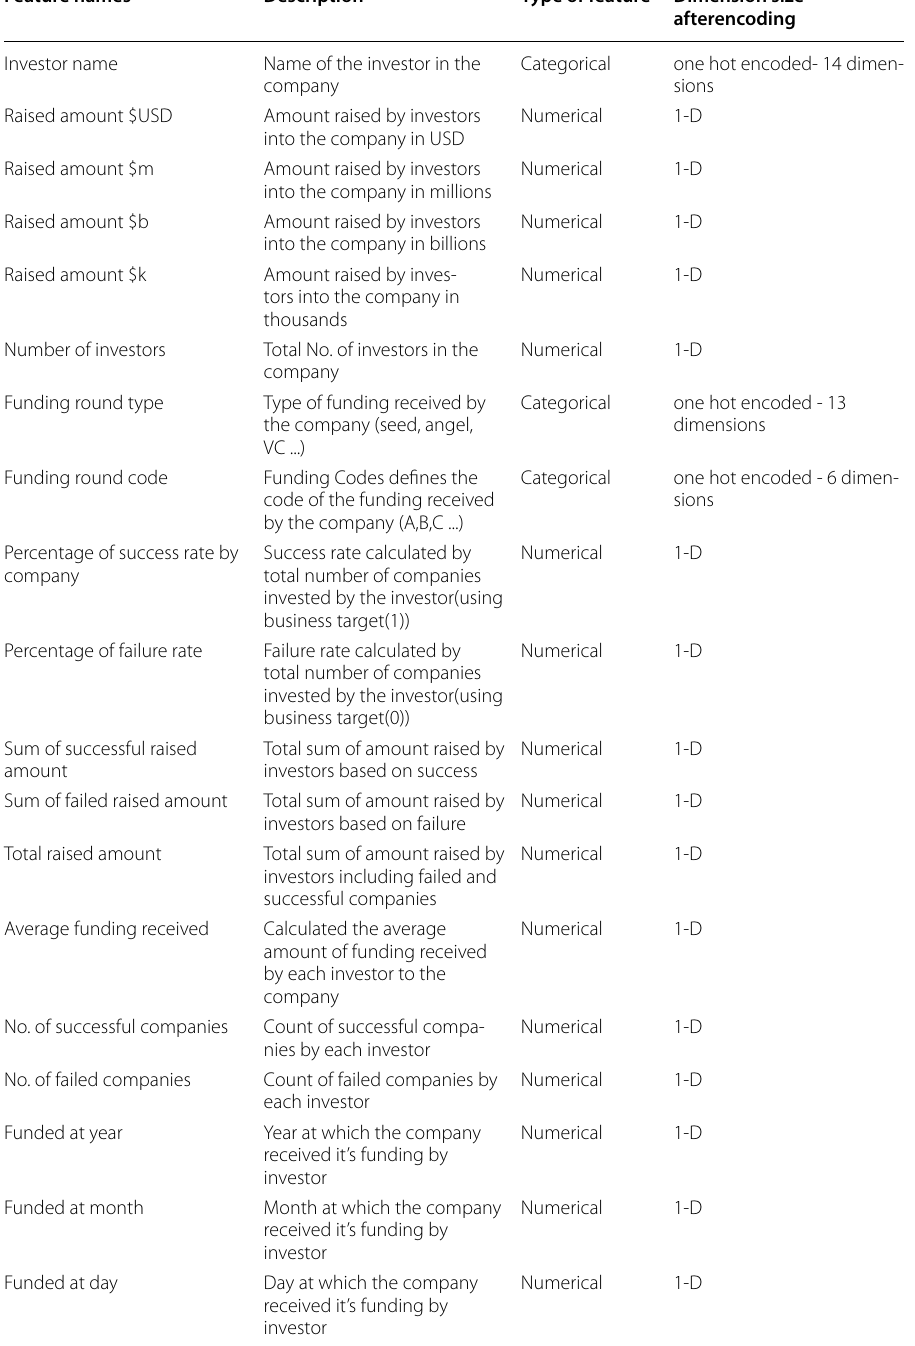
Table 1 A description of Investor Features used in the prediction model Feature